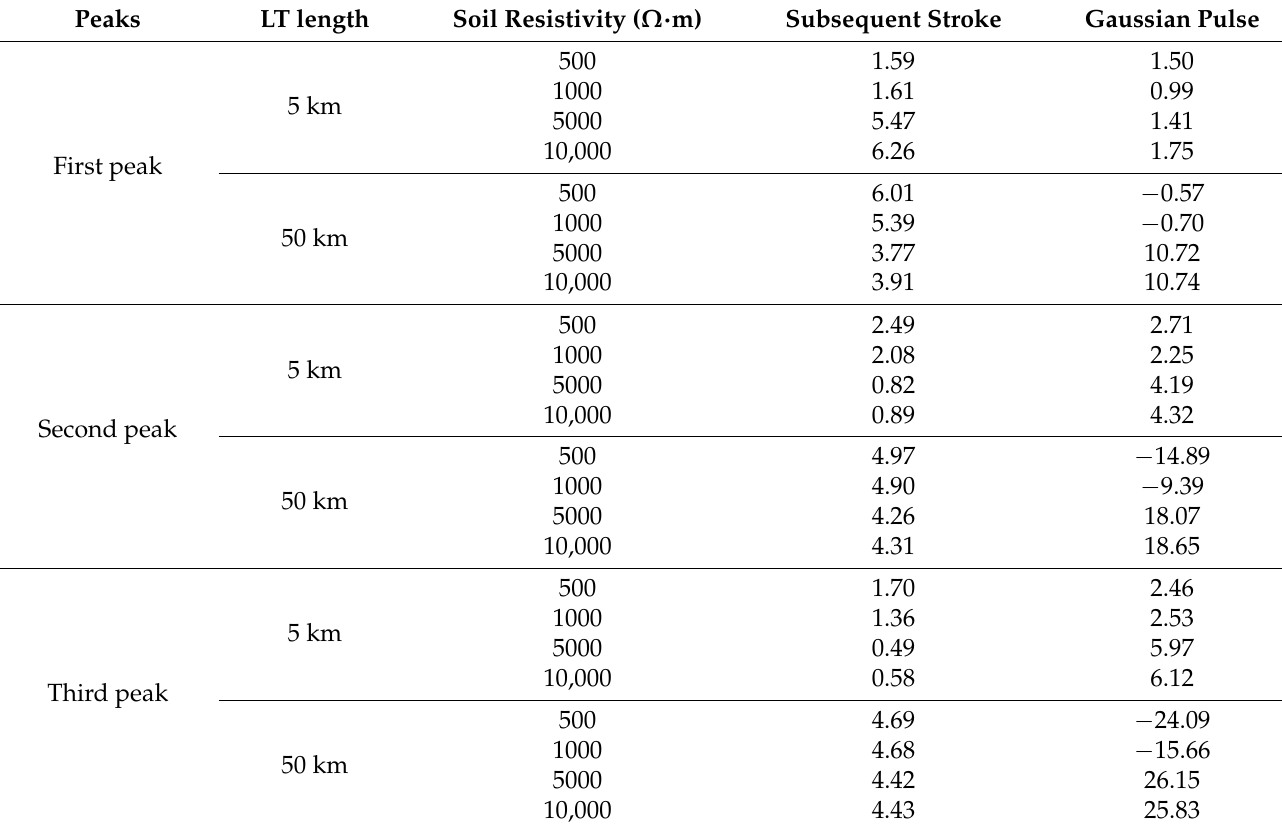
Table 4. Percentage deviation for the transient voltages on the phase-1 generated on the single-circuit line located on the high-resistive